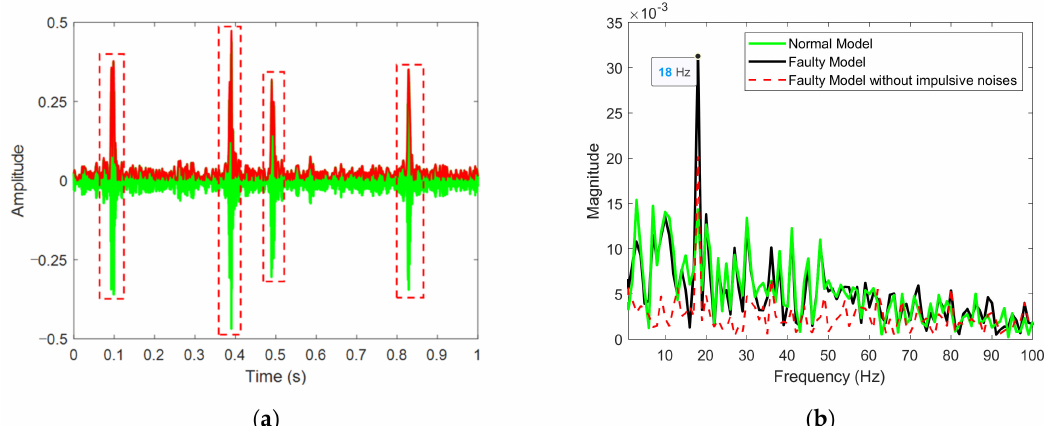
Figure 5. Case where impulsive noises are contained four times at around 0.1, 0.4, 0.5, and 0.8 s. ( a ) Filtered normal signal and ( b ) envelope spectrum.